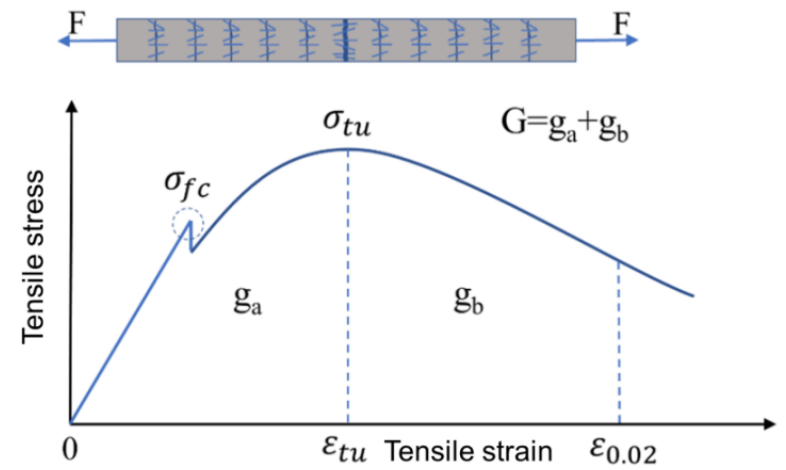
Figure 14 . Schematic diagram of the energy absorption capacity of UHPC. Figure 14. Schematic diagram of the energy absorption capacity of UHPC. In order to quantify the energy absorption capacity of the UHPC during the total stretching process, g b and G were introduced. g b was defined as the energy absorption capacity of the softening section of the UHPC. The energy of the softening section g b was calculated in the interval from ε tu to ε = 0.020. When the tensile strain reached 0.020, the tensile stress generally decreased to below 50% of the peak stress. Most of the fibers failed, and the residual energy of the UHPC was less. g b can be expressed in Equation (2).